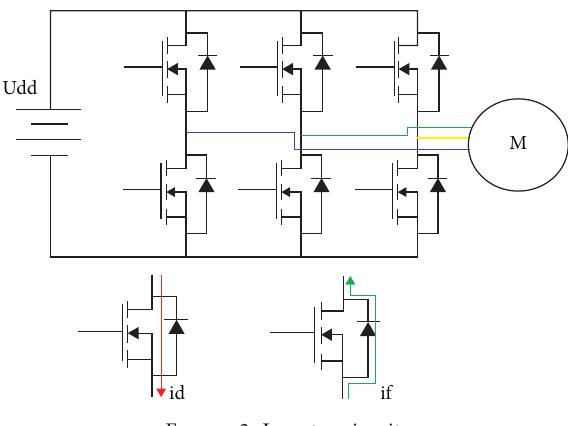
Figure 2: Inverter